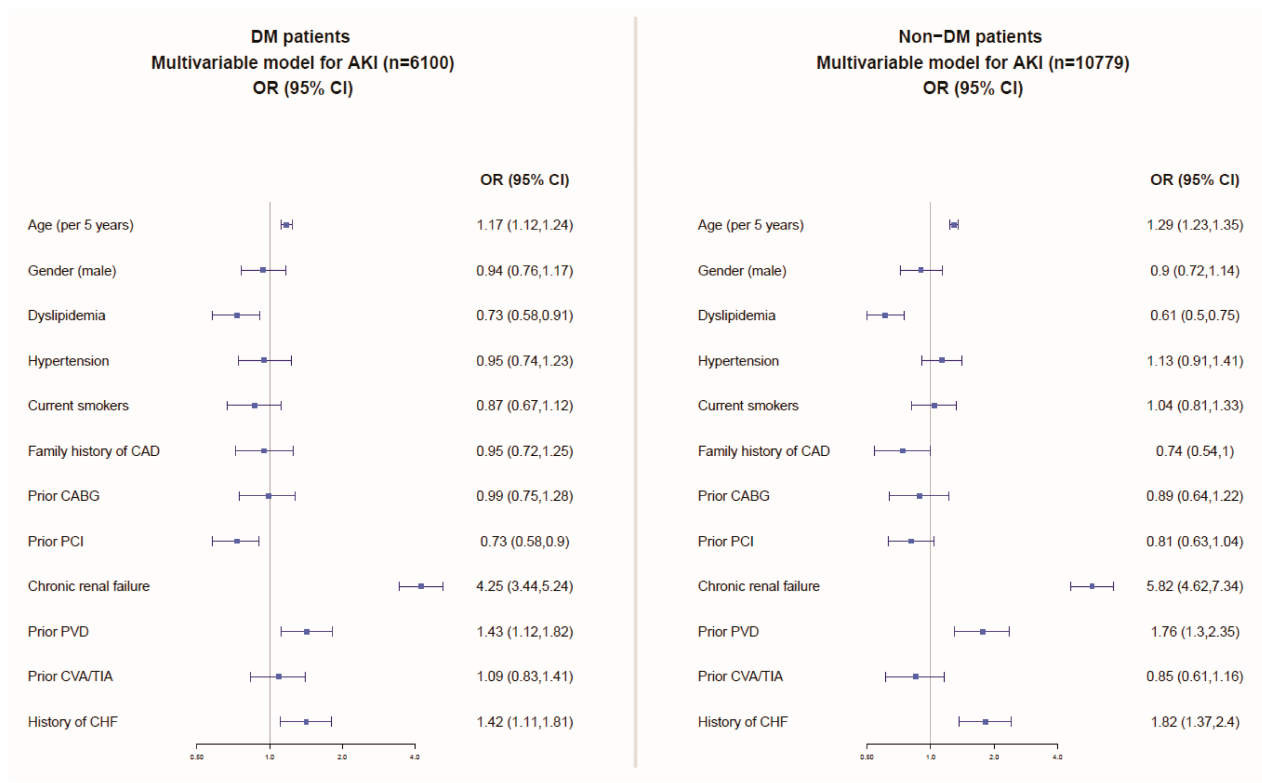
Figure 2. Multivariable model for the prediction of AKI among patients with and without DM. CHF: congestive heart failure; CAD: coronary artery disease; MI: myocardial infarction; TIA: transient ischemic attack; CVA: cerebrovascular attack; PVD: peripheral vascular (arterial) disease; PCI: percutaneous coronary interventional; CABG: coronary artery bypass graft